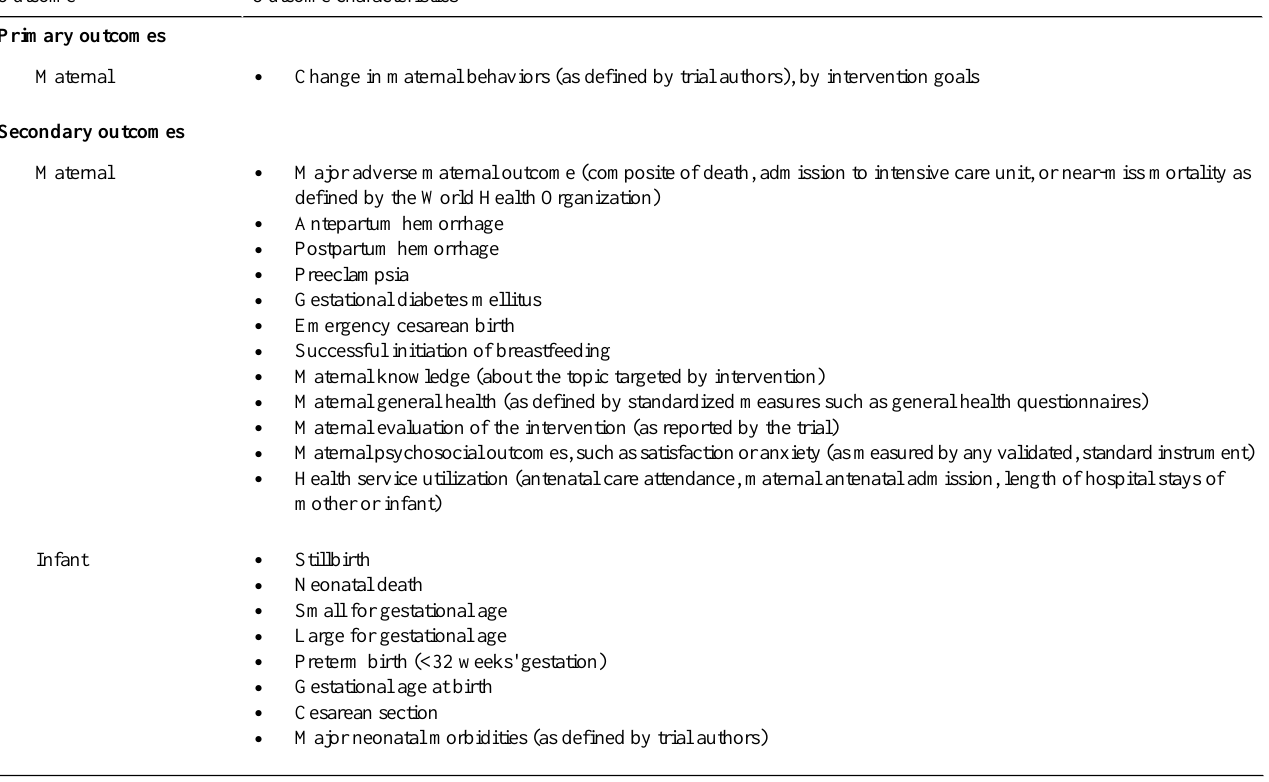
Table 1. Primary and secondary outcome